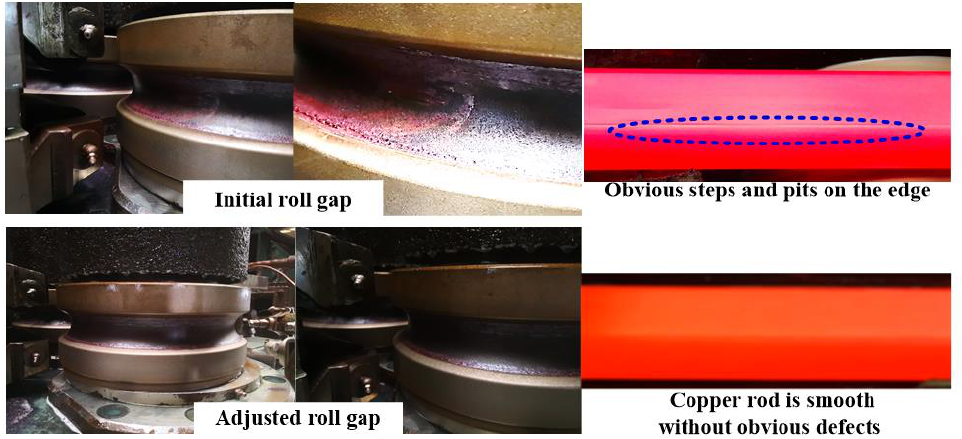
Figure13. Regulating the 2# roll gap roll surface and copper rod surface. Figure 13. Regulating the 2# roll gap roll surface and copper rod